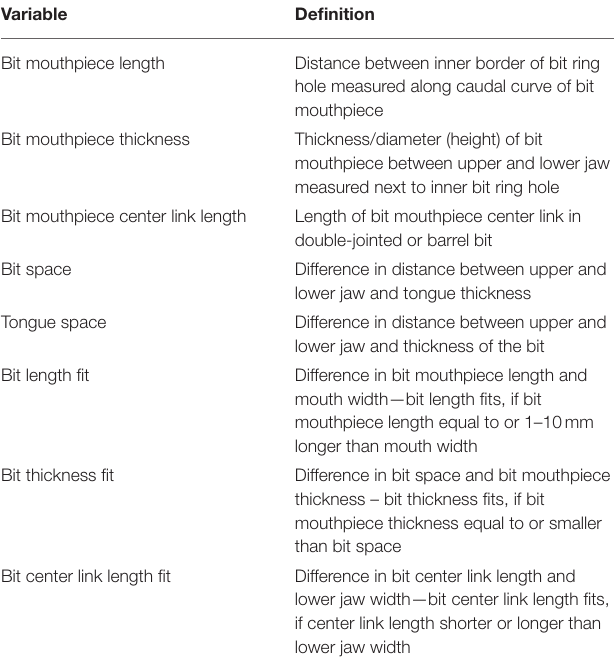
TABLE 2 | Definitions of bit size and bit